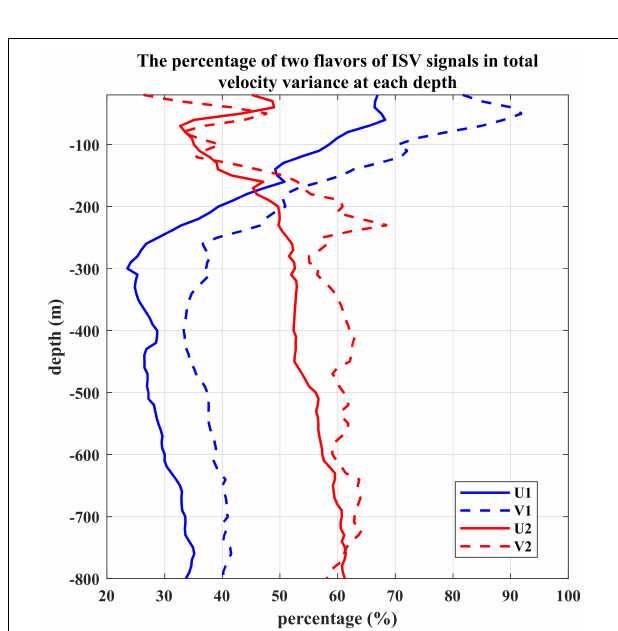
FIGURE 5 | The percentage of two flavors of ISV signals in the total velocity variance at each depth derived from the mooring ADCP measurements. U1 and V1 indicate zonal and meridional velocities after 10–60 days band-pass filter. U2 and V2 indicate zonal and meridional velocities after 60–150 days band-pass